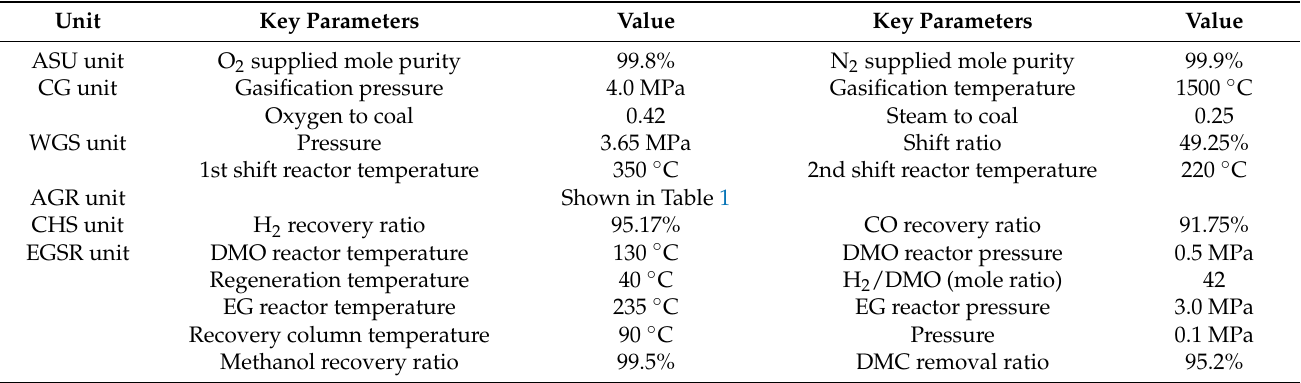
Table 2. Key parameters for modeling and simulation of four CTEG processes.